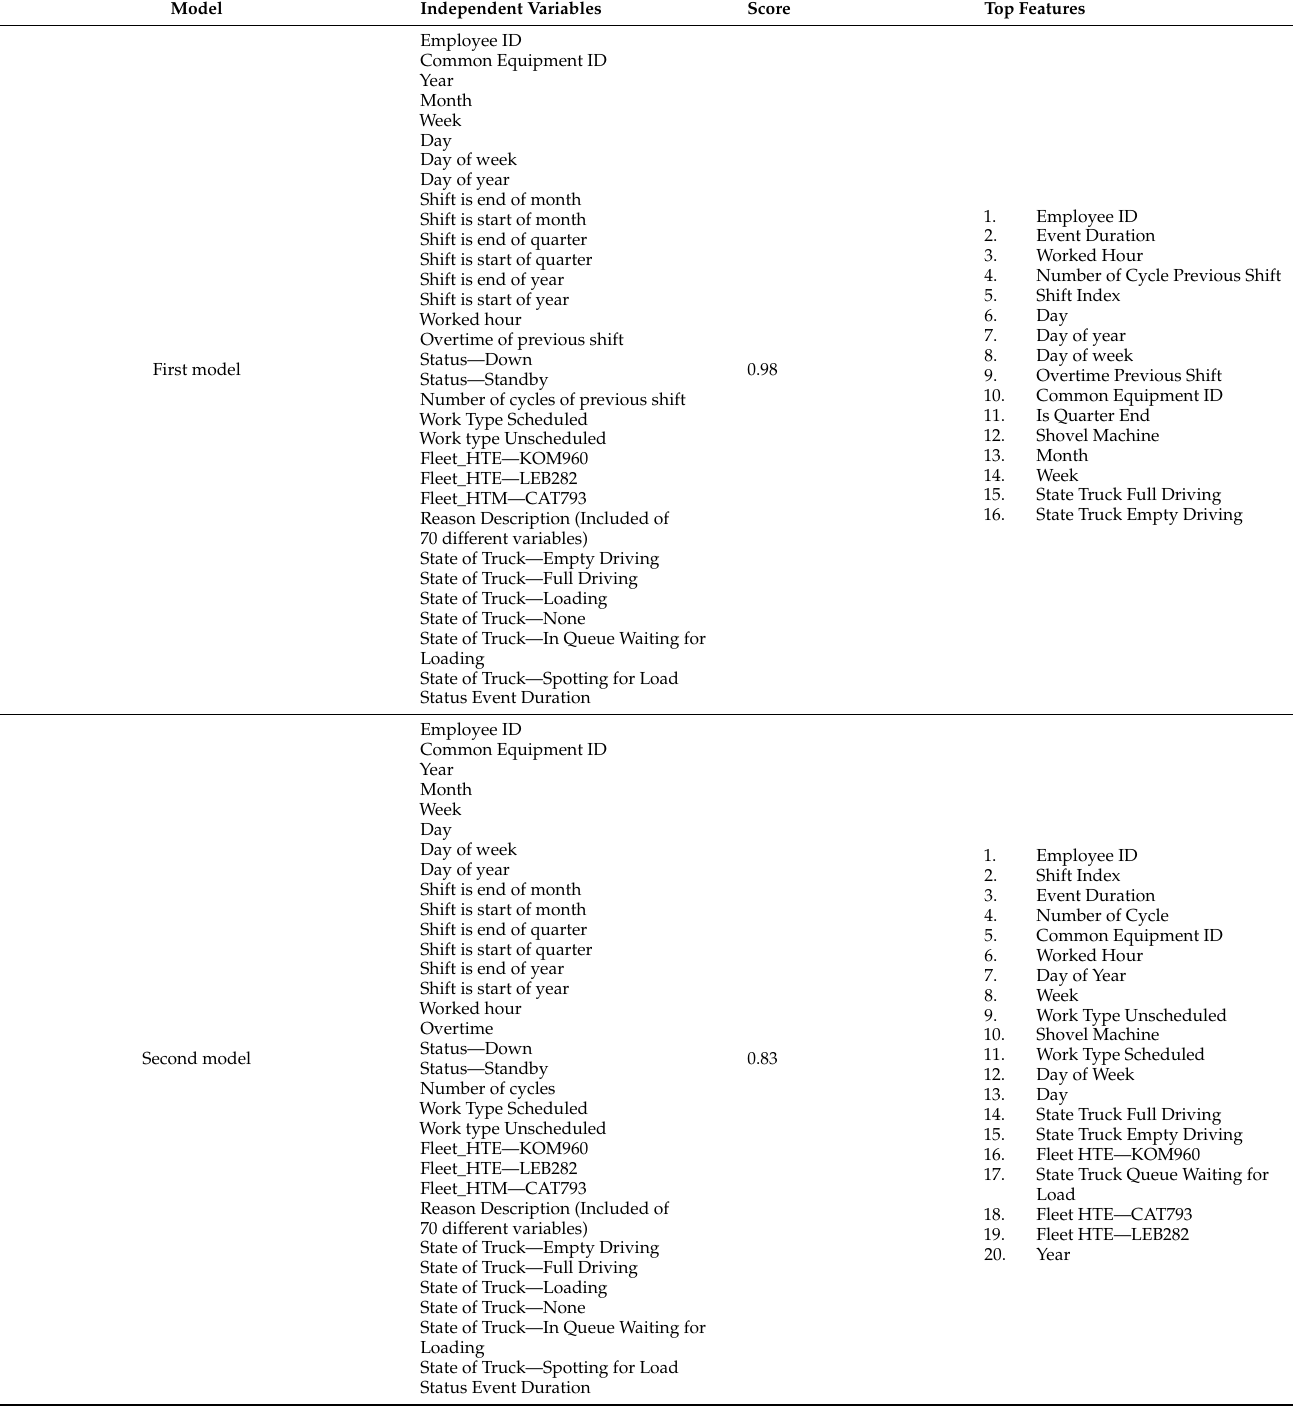
Table 4. Model performance